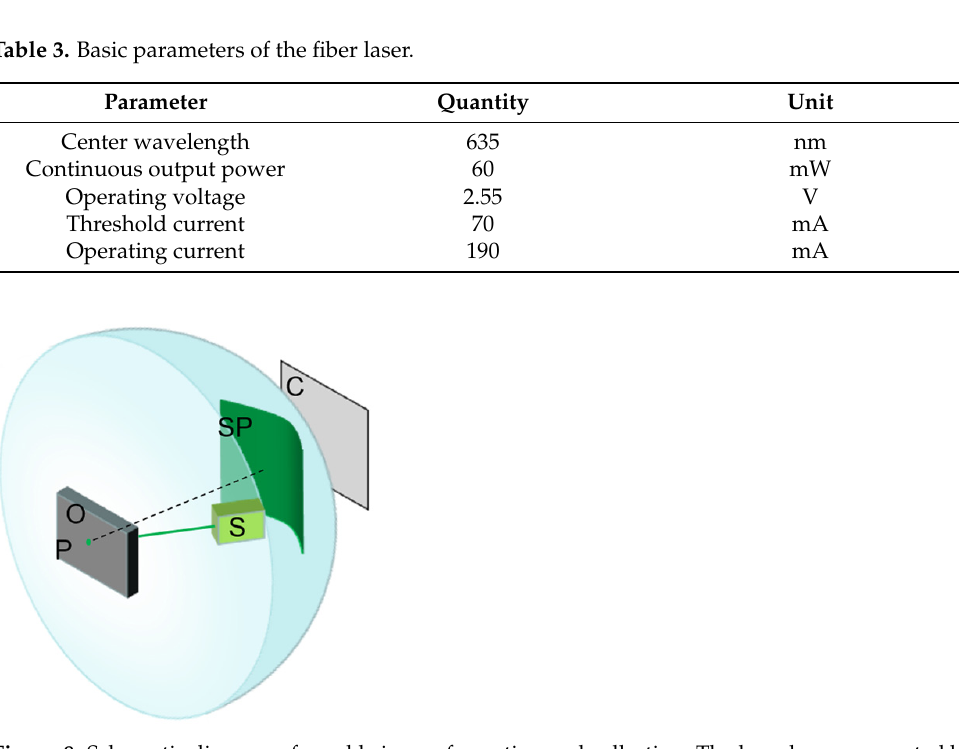
Figure 8. Schematic diagram of speckle image formation and collection. The laser beam generated by laser S irradiates on object O with a rough surface near the sound source (P is a point on object O surface), and then the reflected light interferes to form speckle. C is the camera sensor (the size is exaggerated).